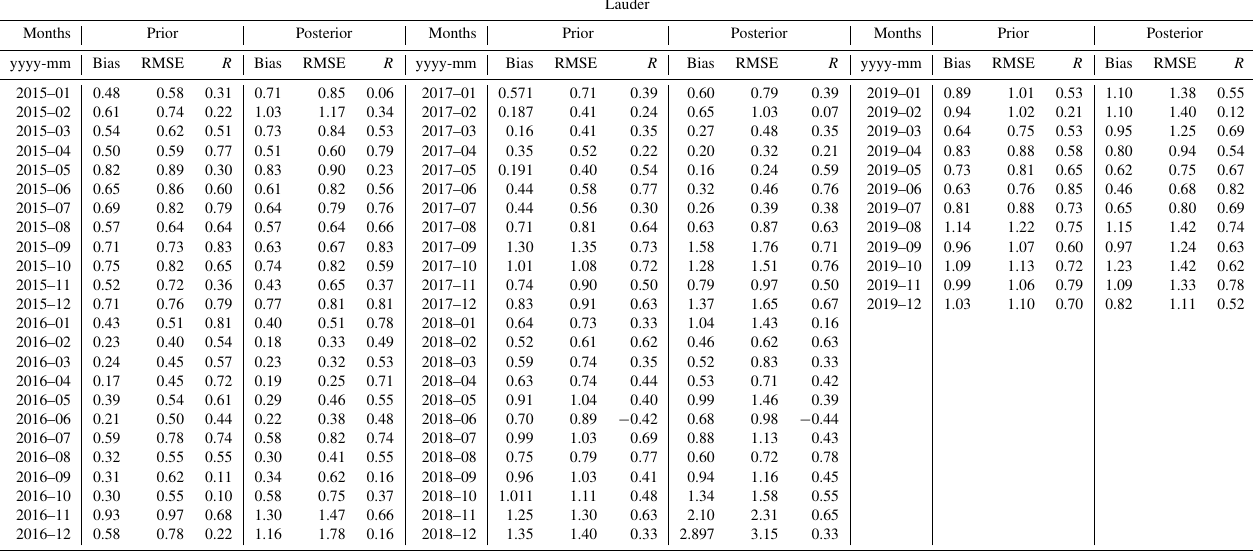
Table F2. Analysis of the residual between CMAQ prior and posterior simulation values and the TCCON Lauder site for the 2015–2019 period, showing the averaged bias (Bias), root-mean-square error (RMSE), and Pearson coefficient ( R ). Lauder Months Prior Posterior Months Prior Posterior Months Prior Posterior yyyy-mm Bias